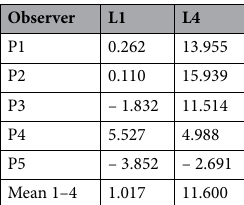
Table 2. The optimal weightings of Level 1 and Level 4, for a computational model of metallicity fit to observer